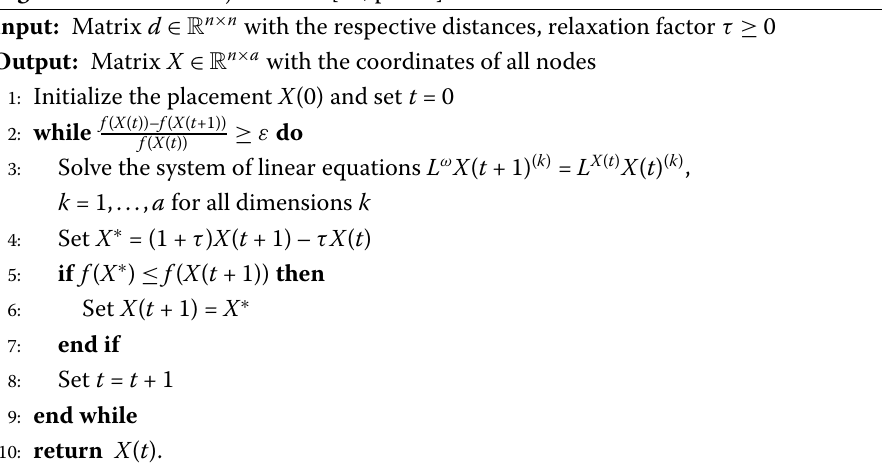
Algorithm 1 Stress majorization [29, p.